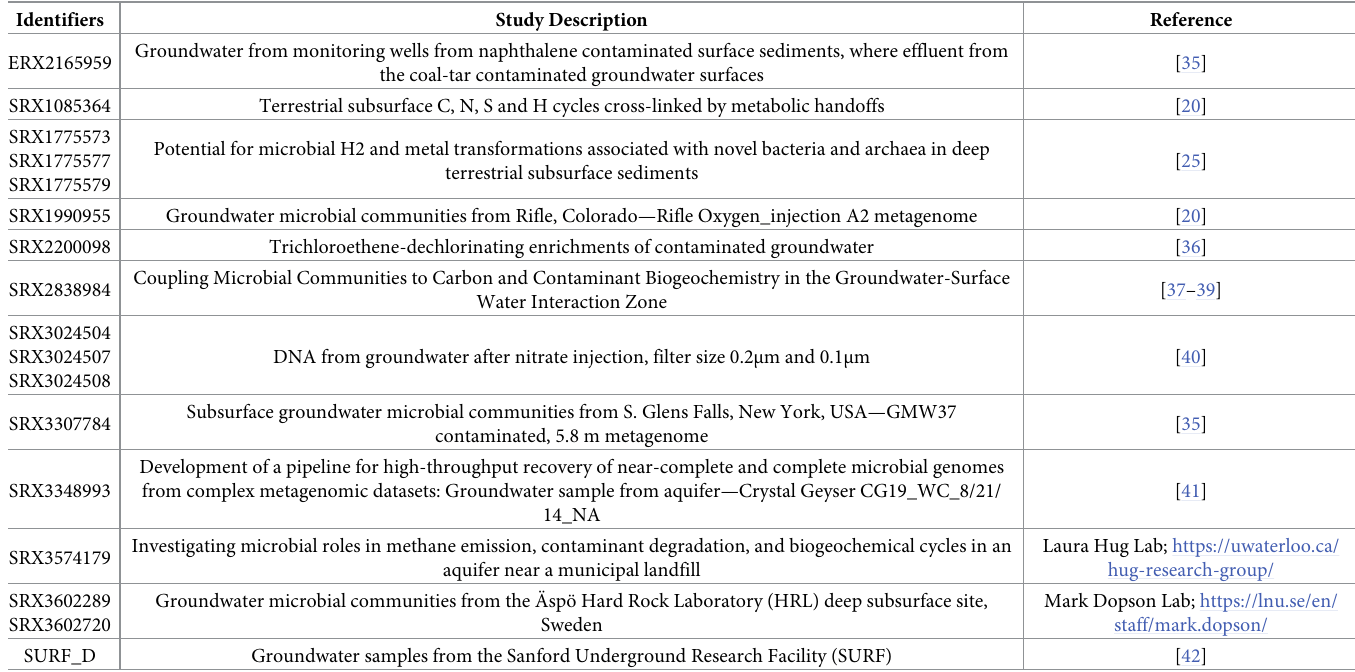
Table 1. Description of metagenomes in this